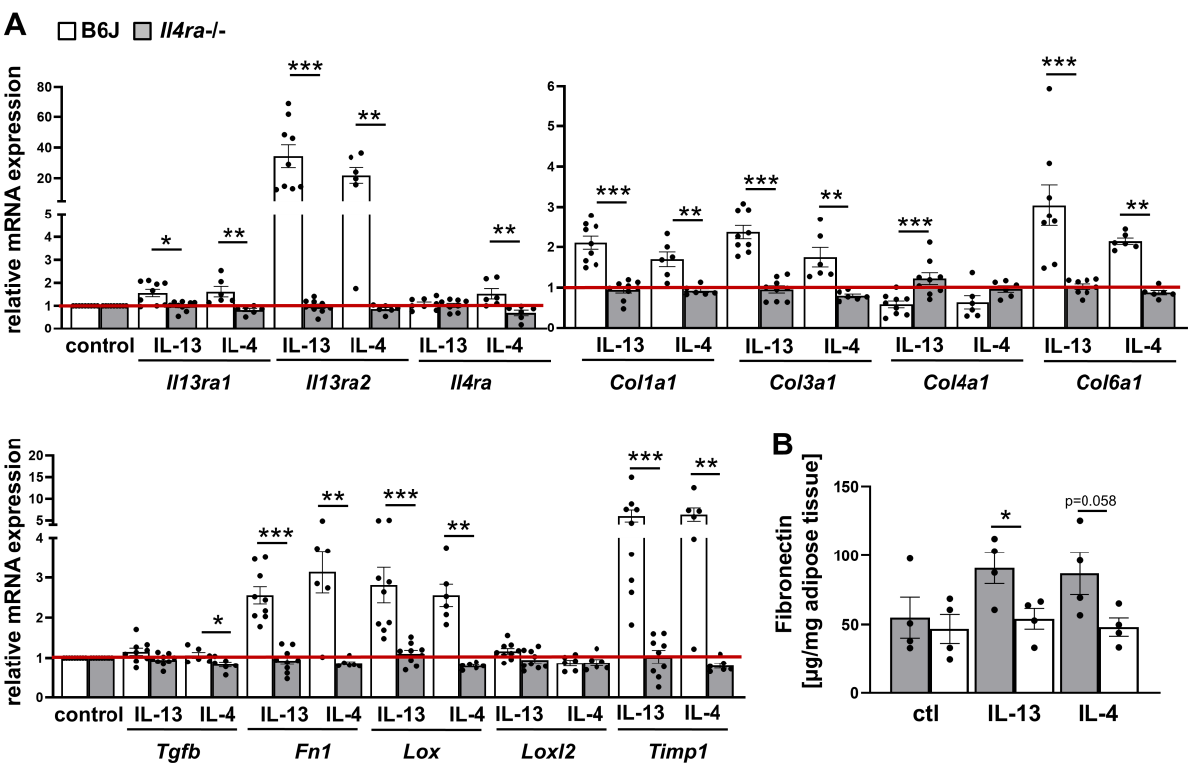
Figure 3. WAT explants from Il4ra − / − mice show no response to IL-13 and IL-4 stimulation. WAT explants from Il4ra − / − mice (n = 6–9) and control B6J mice (n = 6–9) were stimulated with either IL-13 (50 ng/mL) or IL-4 (50 ng/mL) or not (control) for four days. ( A ) mRNA expression of cytokine receptors and fibrosis-related genes were determined in stimulated explants and represented as relative changes to the control group (B6J). ( B ) Fibronectin content was measured in the supernatant of cultured explants by ELISA. All data were represented as mean ± SEM. * p -value < 0.05; ** p -value < 0.01; *** p -value < 0.001. The red line indicates the level of the control